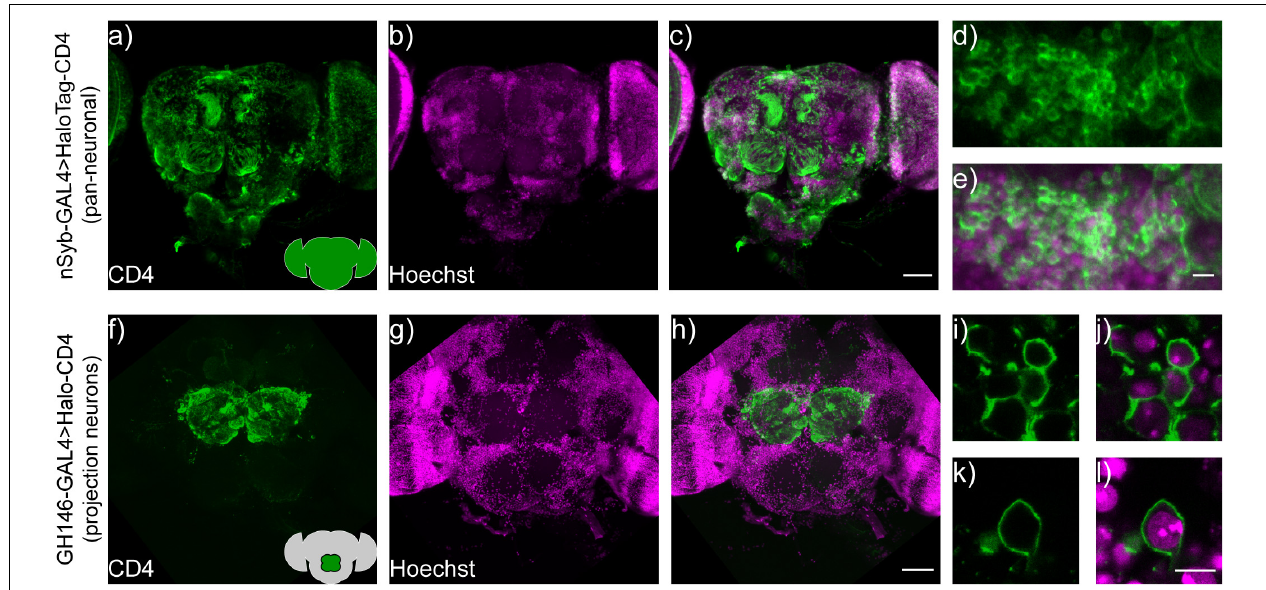
FIGURE 5 | HaloTag-CD4 expression in transgenic Drosophila . (a) nSyb-GAL4, HaloTag-CD4 brains express CD4 pan-neuronally. Maximum z-projection of a confocal fluorescence microscopy stack of brain explant from either (a–e) nSyb-GAL4 > HaloTag-CD4 or (f–l) GH146-GAL4 > HaloTag-CD4, fixed and stained for an extracellular epitope of the CD4 protein (OKT4, green) and counterstained for nuclei with Hoechst 33342 (16 µ m or 10 µ g/mL, magenta). Scale bar is 50 µ m for whole-brain images (a–c,f–h) and 5 µ m for zoomed-in regions (d,e,i–l) . Insets on panels (a,f) show schematized brains with an approximate location of the staining for reference.